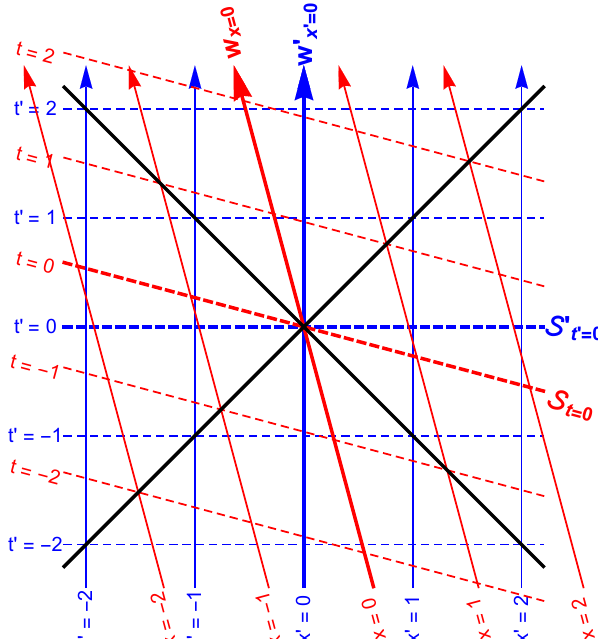
Figure 2. Minkowski spacetime M as charted in time coordinate t (cid:48) and position space coordinate x (cid:48) (other position space dimensions suppressed) by an inertial reference frame (cid:79) (cid:48) (blue), in units with c = 1, showing also (cid:79) (red) moving with negative velocity in the x (cid:48) direction relative to (cid:79) (cid:48) . This figure is a Lorentz boost or pseudo-rotation of Figure 1, under which the null cones remain